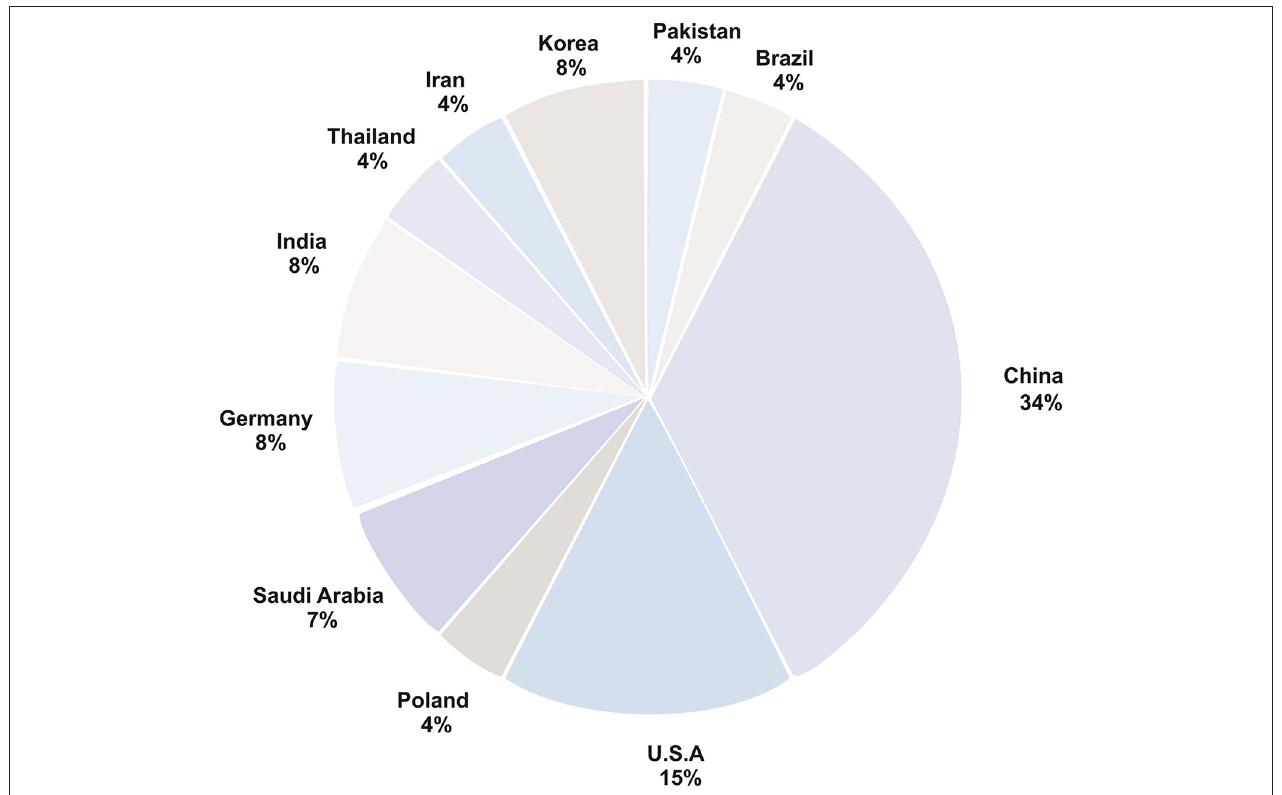
FIGURE 2 | Country-wise distribution of AI based studies for individuals with cleft lip and